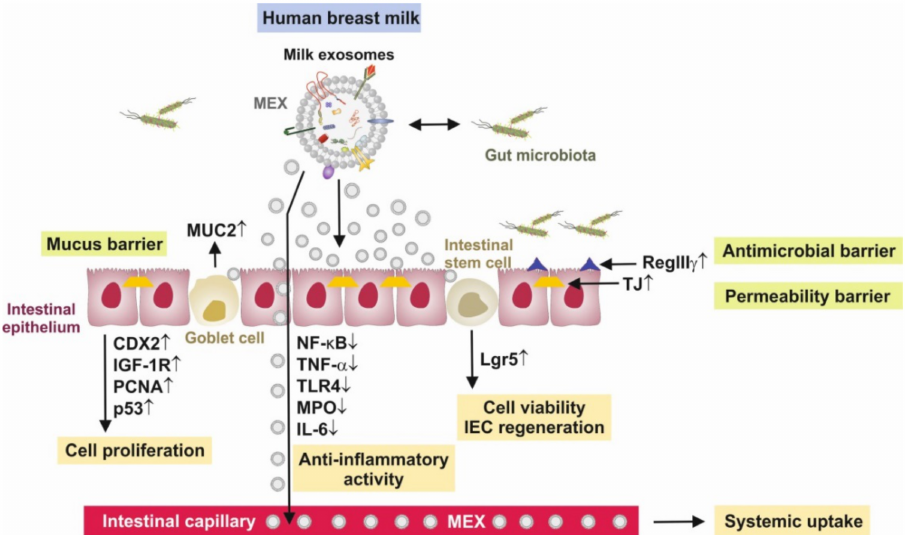
Figure 2. Synopsis of intestinal effects of milk exosomes (MEX). MEX increase intestinal epithe- lial cell proliferation, goblet cell proliferation and activity and enhance the activity and viability of intestinal stem cells with up-regulation of the stem cell marker leucine-rich-repeat-containing G-protein-coupled receptor 5 (Lgr5). MEX support the formation of the mucus barrier and increase the production of mucin 2 (MUC2), and exert anti-inflammatory activities via the suppression of nuclear factor κ B signaling, tumor necrosis factor- α (TNF- α ), toll-like receptor 4 (TLR4), myeloper- oxidase (MPO) and interleukin 6 (IL-6). Furthermore, MEX support the anti-microbial barrier via up-regulation of the anti-bacterial lectin regenerating islet-derived 3 γ (RegIII γ ) and induce the ex- pression of tight junction (TJ) proteins zonula occludens 1, claudin and occludin. Furthermore, MEX directly interact with bacteria of the gut